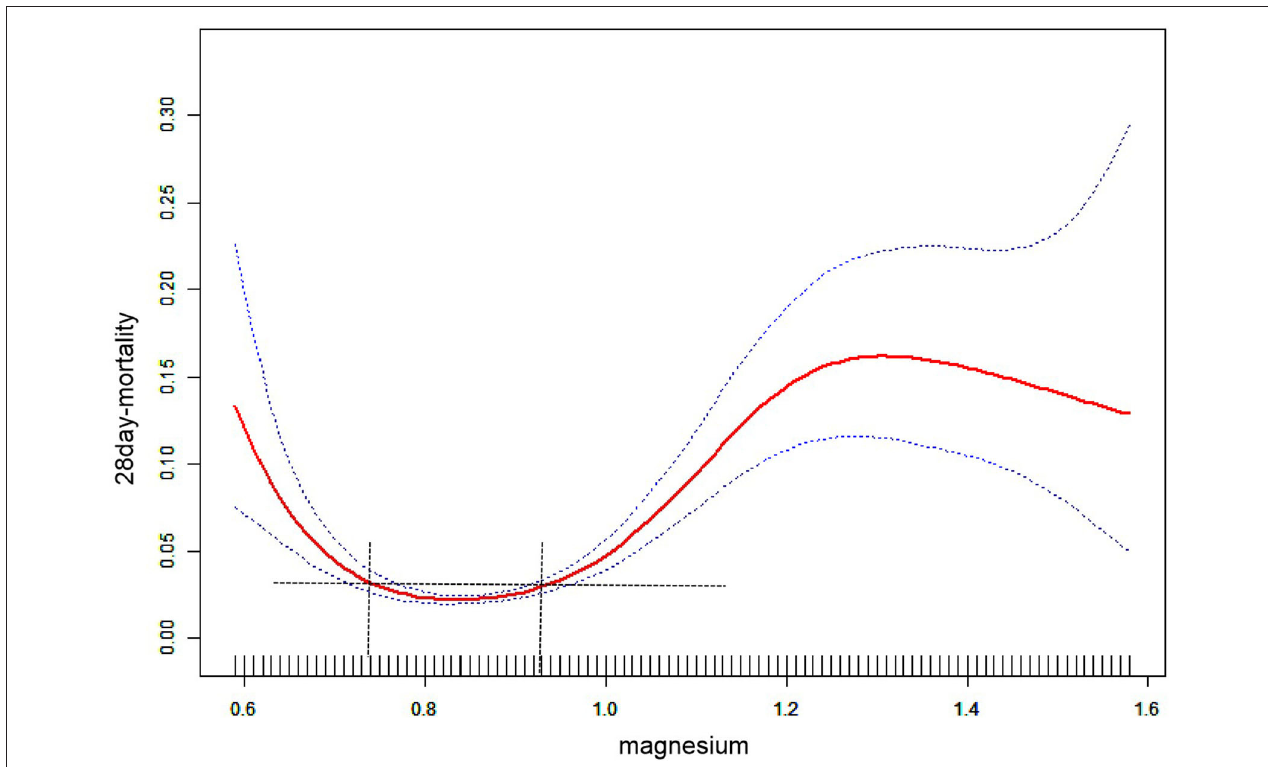
FIGURE 2 | The association between magnesium and 28-day in-hospital all-cause mortality. The red line represents the fitted curve of magnesium and 28-day mortality, and the blue line represents the 95% confidence interval of the curve.